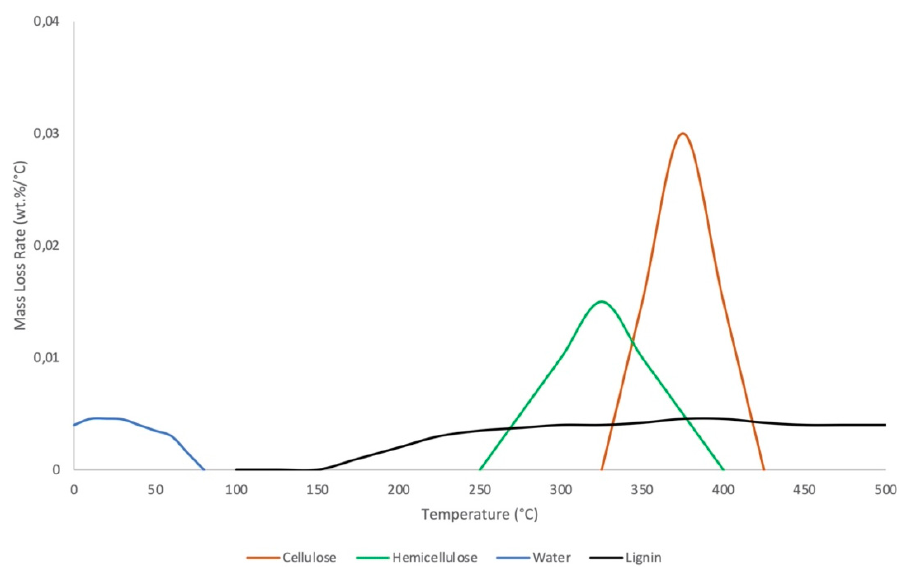
Figure 1. The rate of thermal decomposition of cellulose, hemicellulose, and lignin with moisture/water operating within pyrolysis temperature. Adapted with slight modifications from [14].